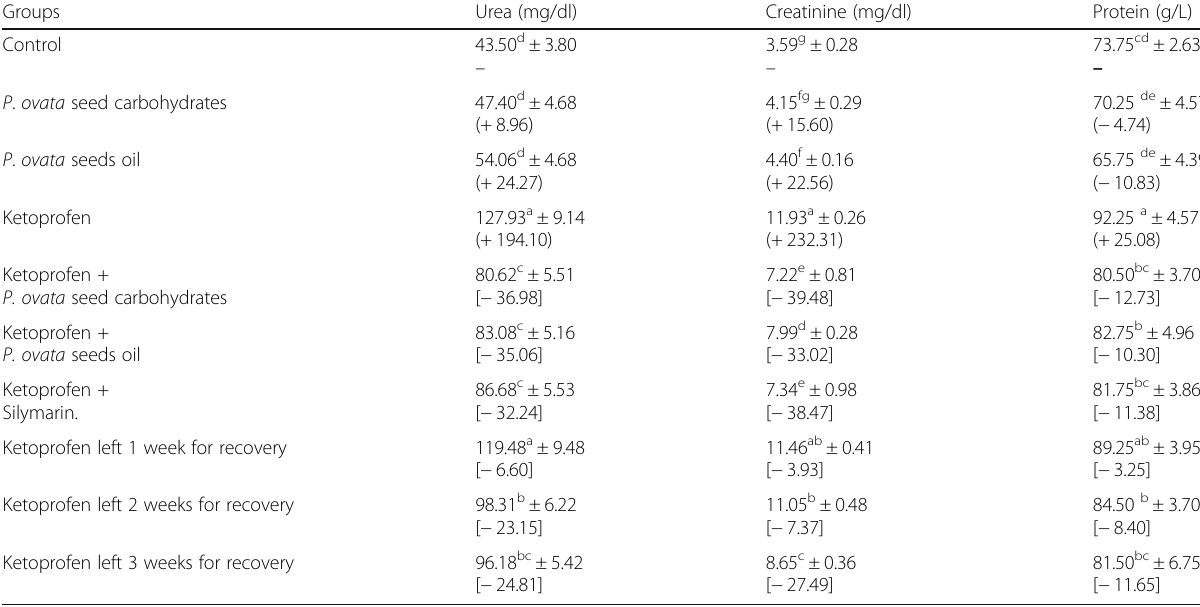
Table 8 Therapeutic effect of P . ovata seed carbohydrates and fixed oil on kidney function indices of ketoprofen toxicity in rats